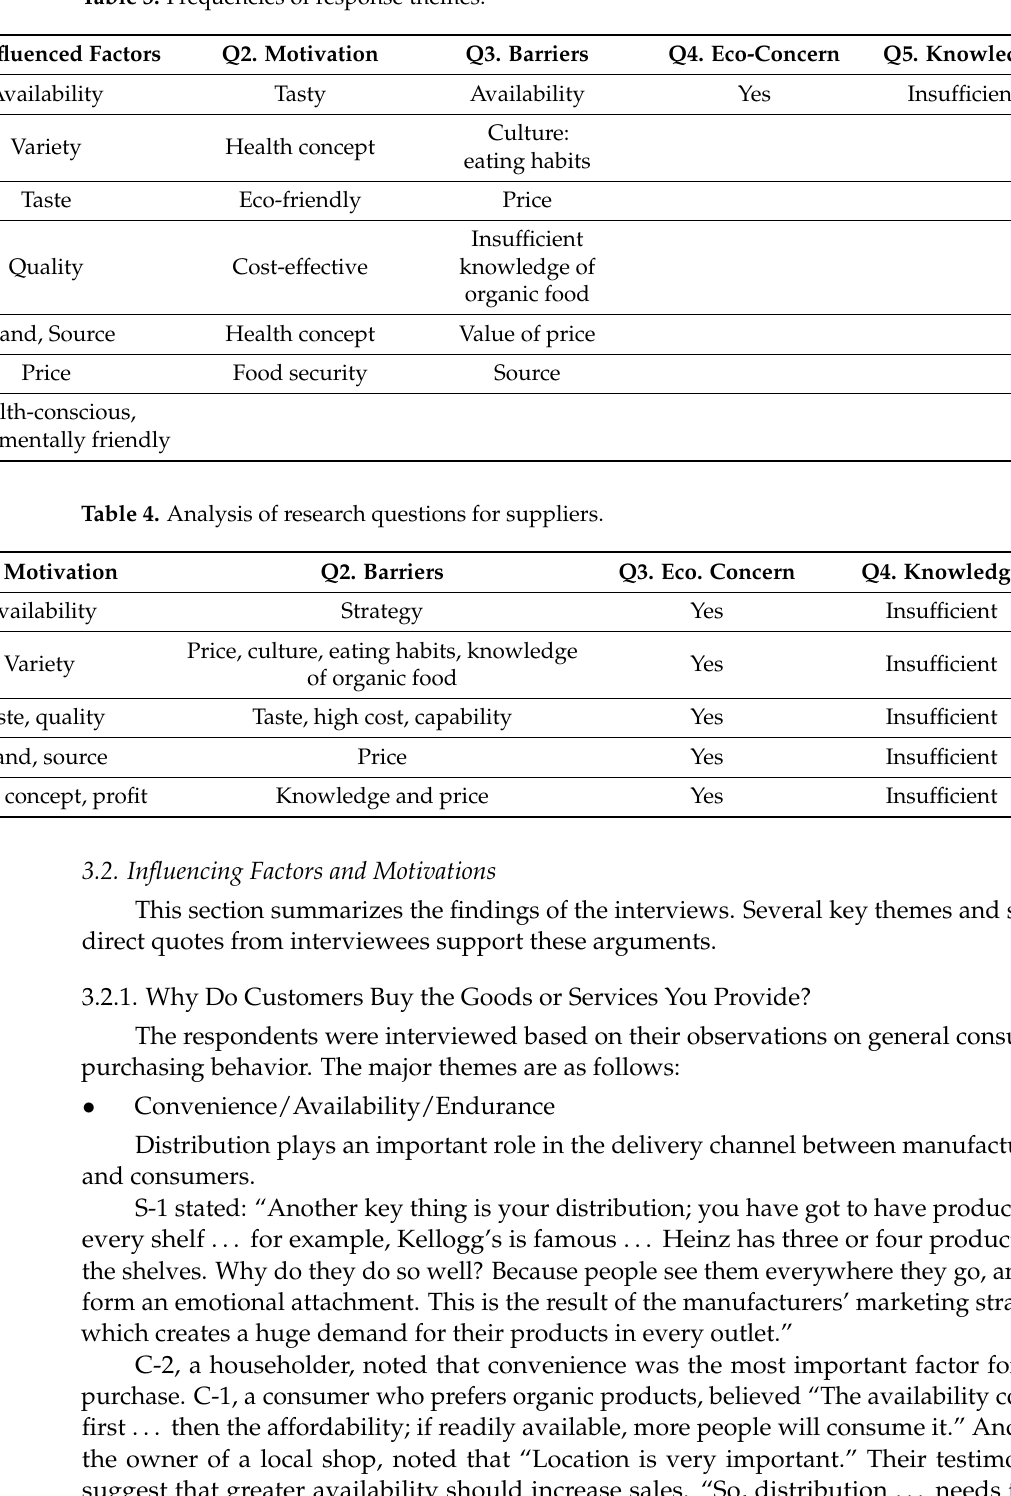
Table 3. Frequencies of response themes.